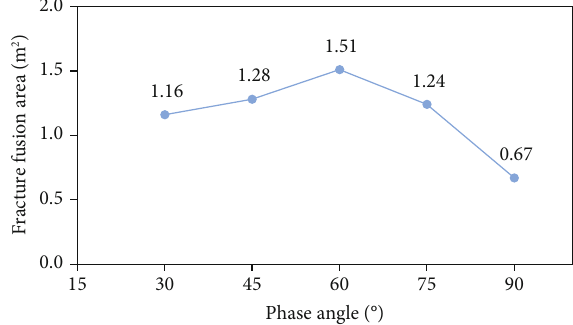
Figure 4: Fracture propagation simulation results of fi xed-plane perforation